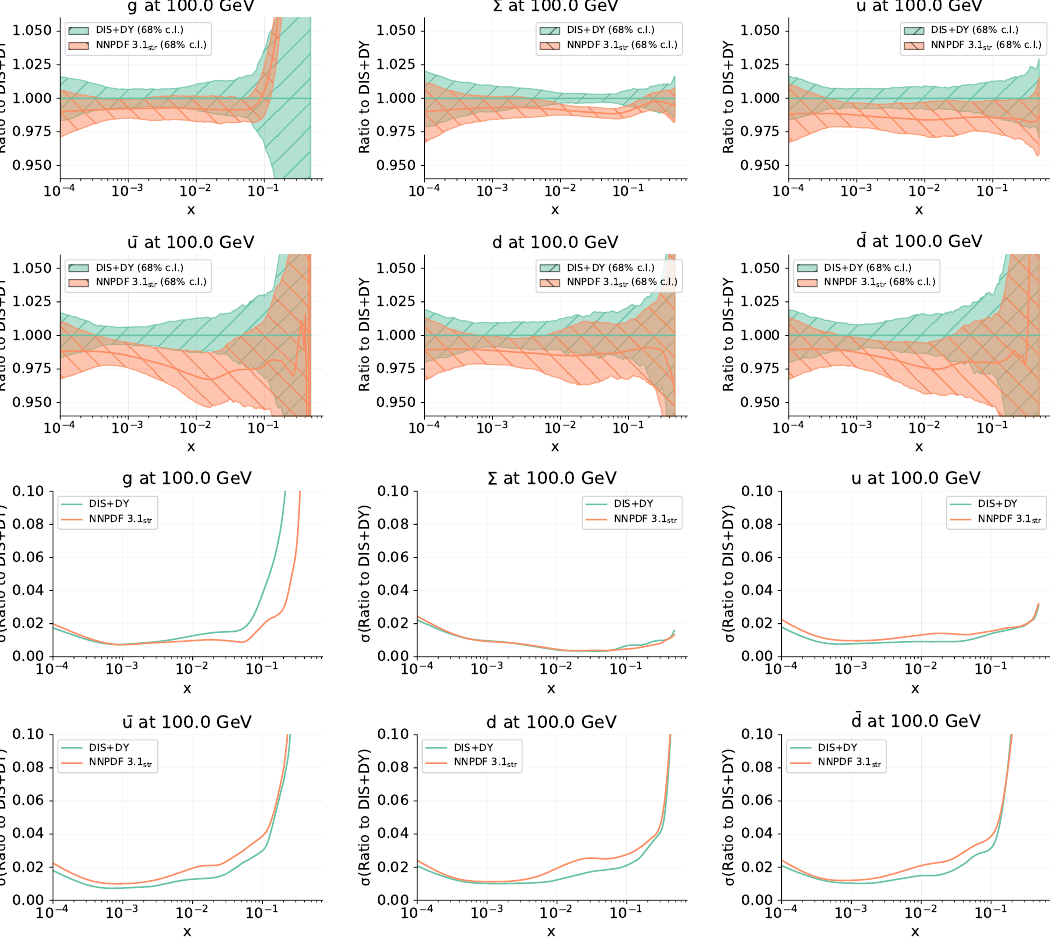
Figure 21 . Same as figure 3 comparing the baseline SM PDF set used in this work (labelled “DIS+DY”) with the global NNPDF3.1_str